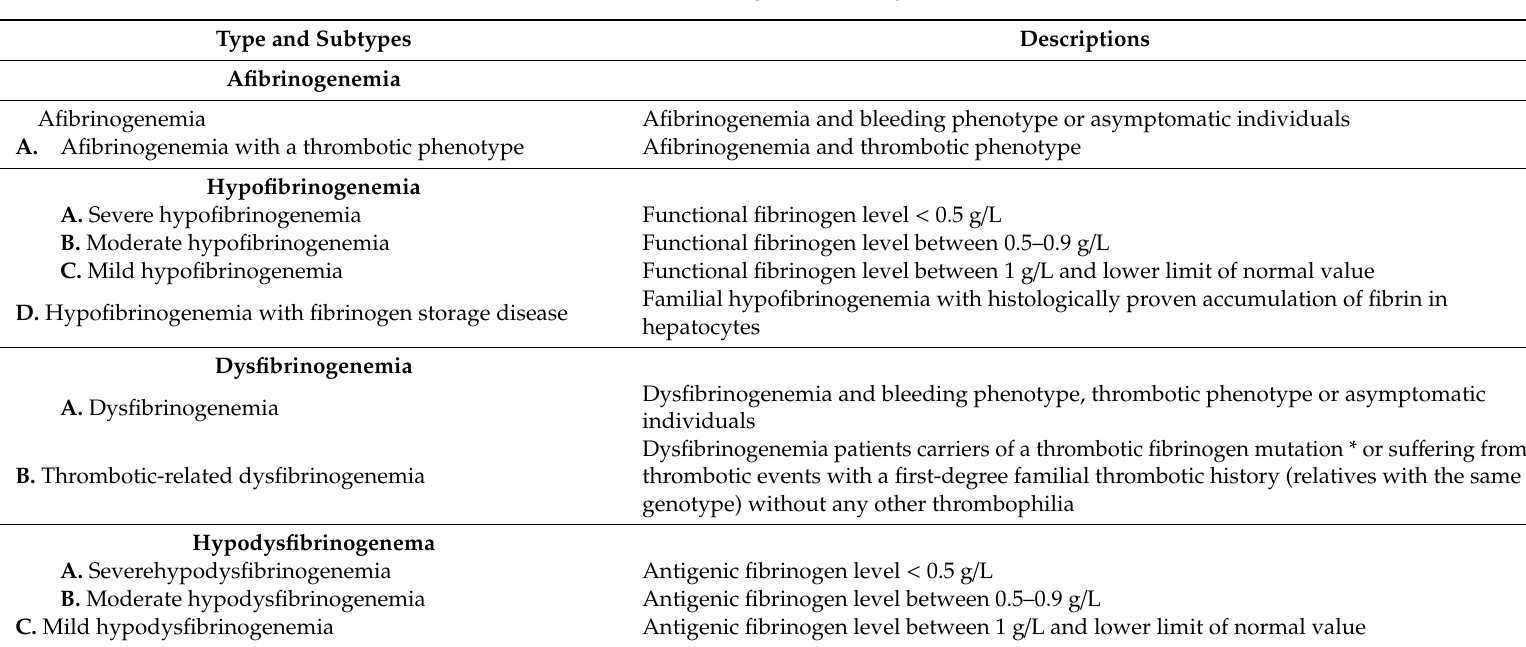
Table 1. Classification of congenital fibrinogen disorders